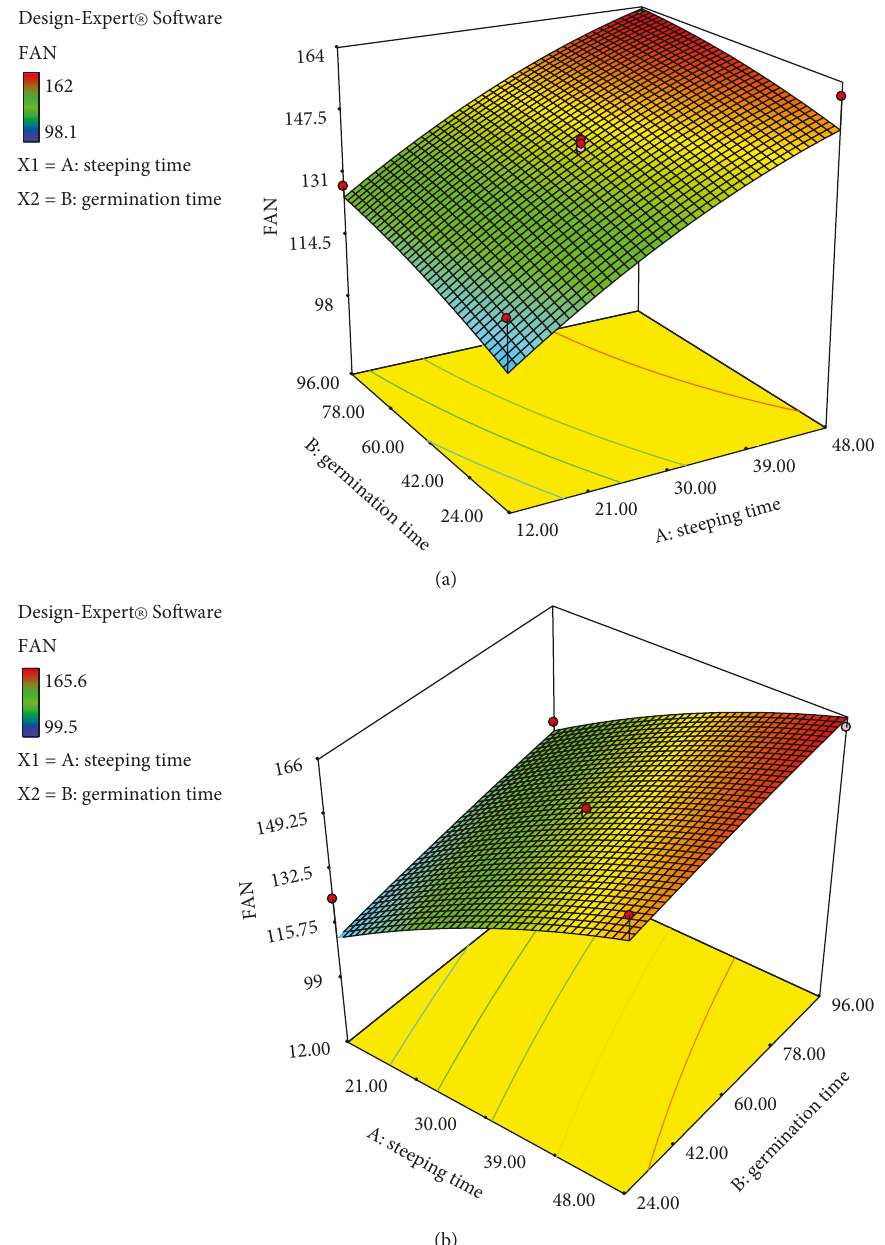
Figure 2: Response surface plots of steeping time and germination time on free amino nitrogen of (a) barley malt and (b) quinoa